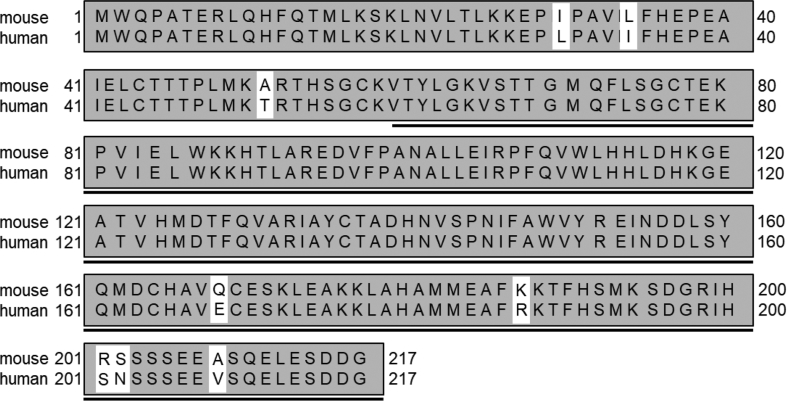
Sequence alignment of human and murine PID1 proteins. Variable amino acids are indicated in white and the phospho-tyrosine binding domain is underlined.